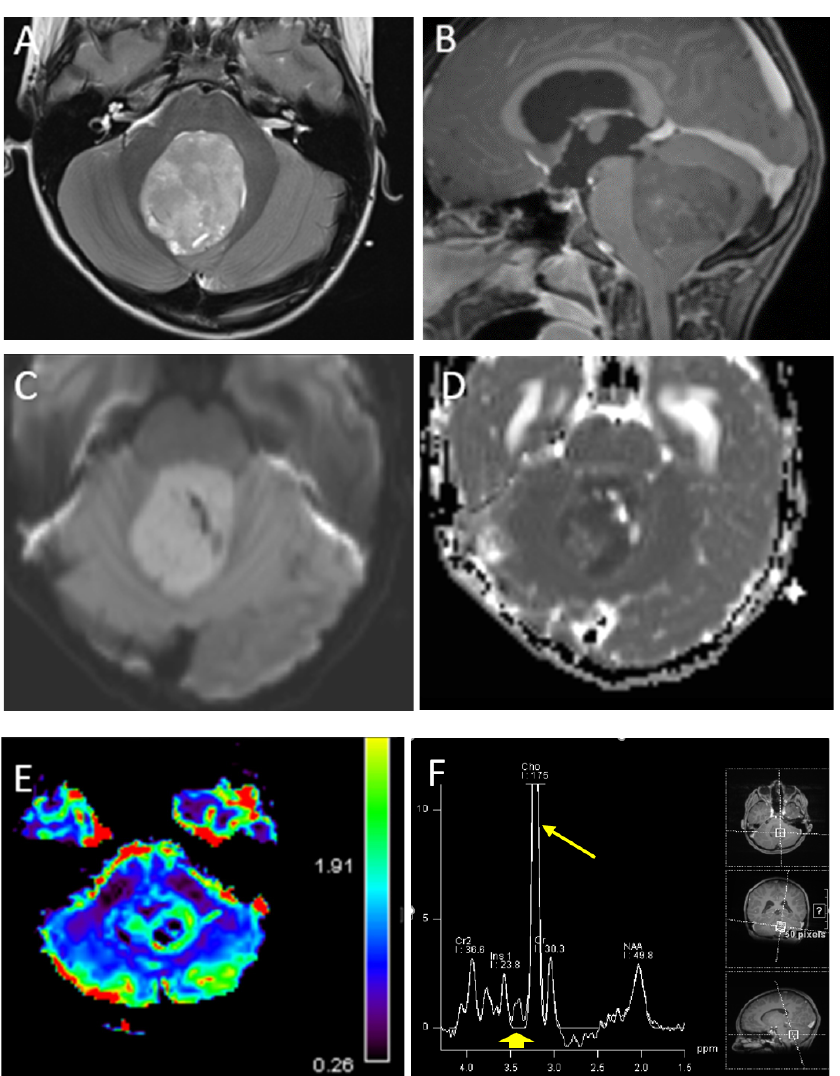
Figure 1. A 7-year-old boy with medulloblastoma. Axial T2 ( A ), sagittal post-contrast T1 ( B ), images demonstrate a mildly heterogeneous midline posterior fossa mass. DWI ( C ) and ADC ( D ) imaging demonstrates diffusion restriction of the lesion relative to the adjacent cerebellar parenchyma, typical of these highly cellular neoplasms. Perfusion imaging ( E ) demonstrates increased relative cerebral blood volume within the lesion and MRS ( F ) demonstrates a high choline peak (long arrow) as well as a small taurine peak (short arrow).